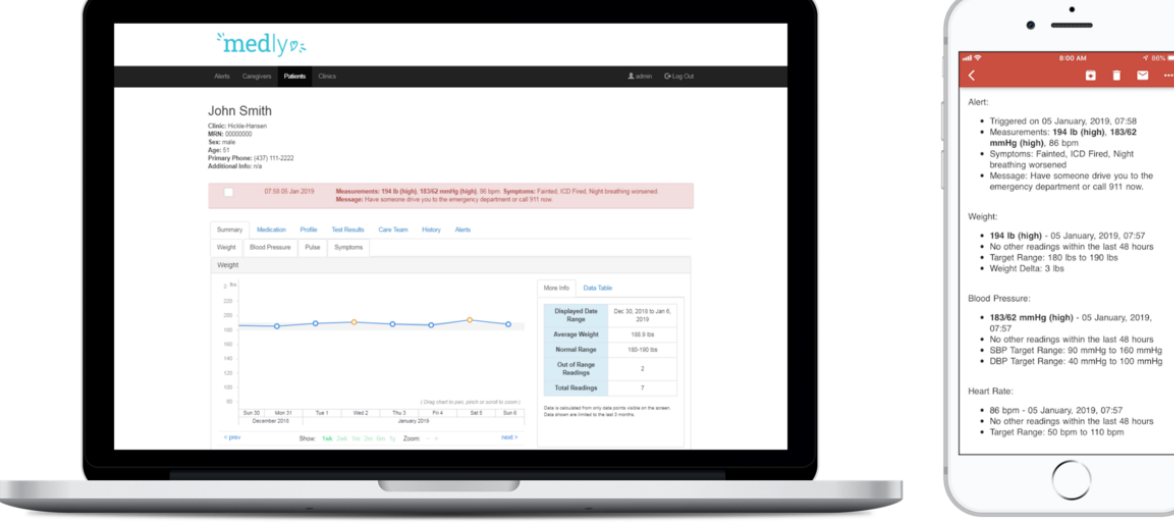
Intended Use: Supporting Clinical and Operational